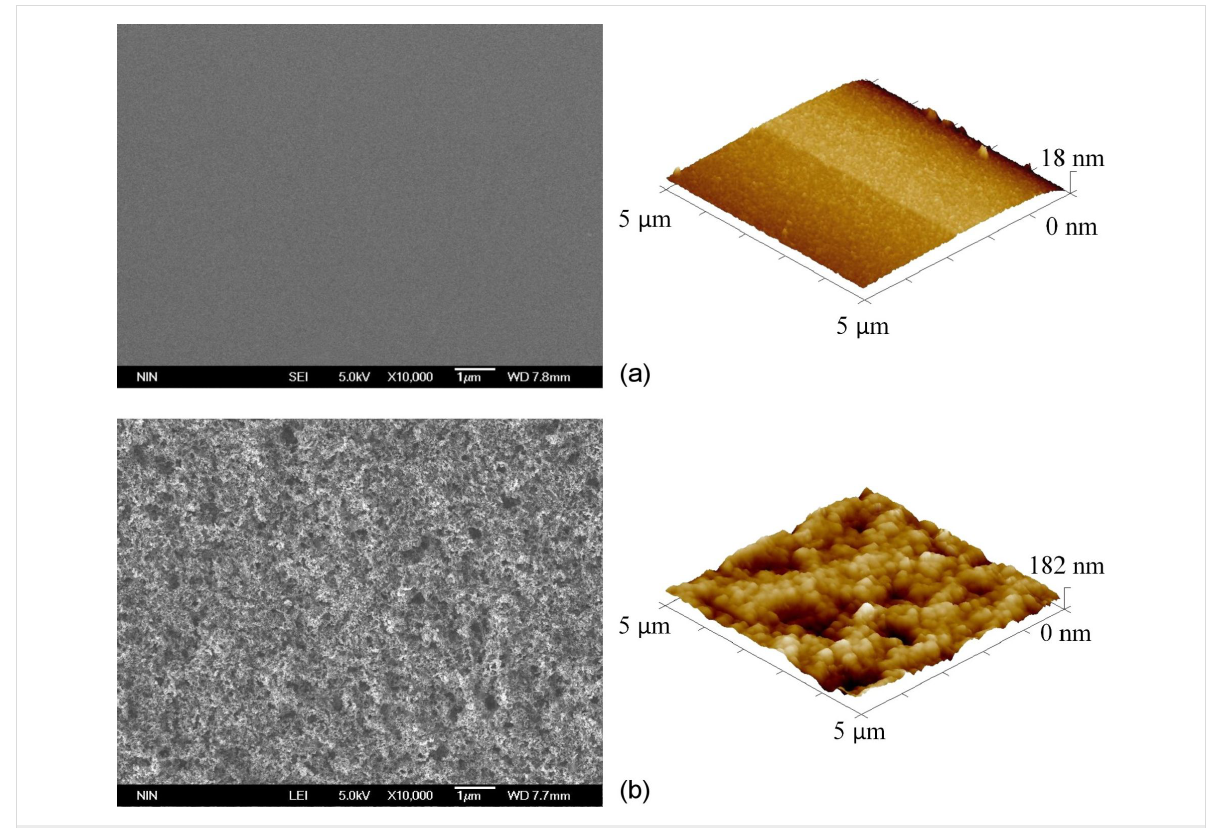
Figure 2: SEM and AFM images of a glass slide a) before and b) after the spray coating procedure.